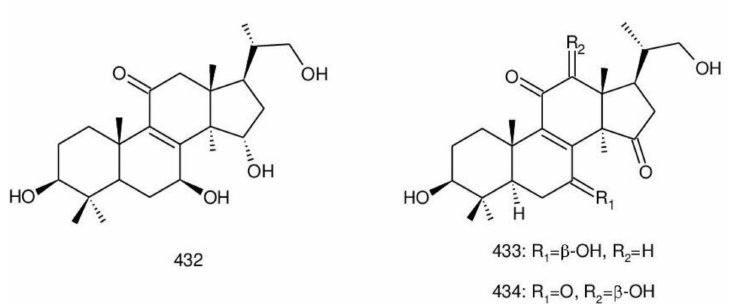
Figure 14. C25 Triterpenoids: the possible producing-pathway of 432 in G. sinense .